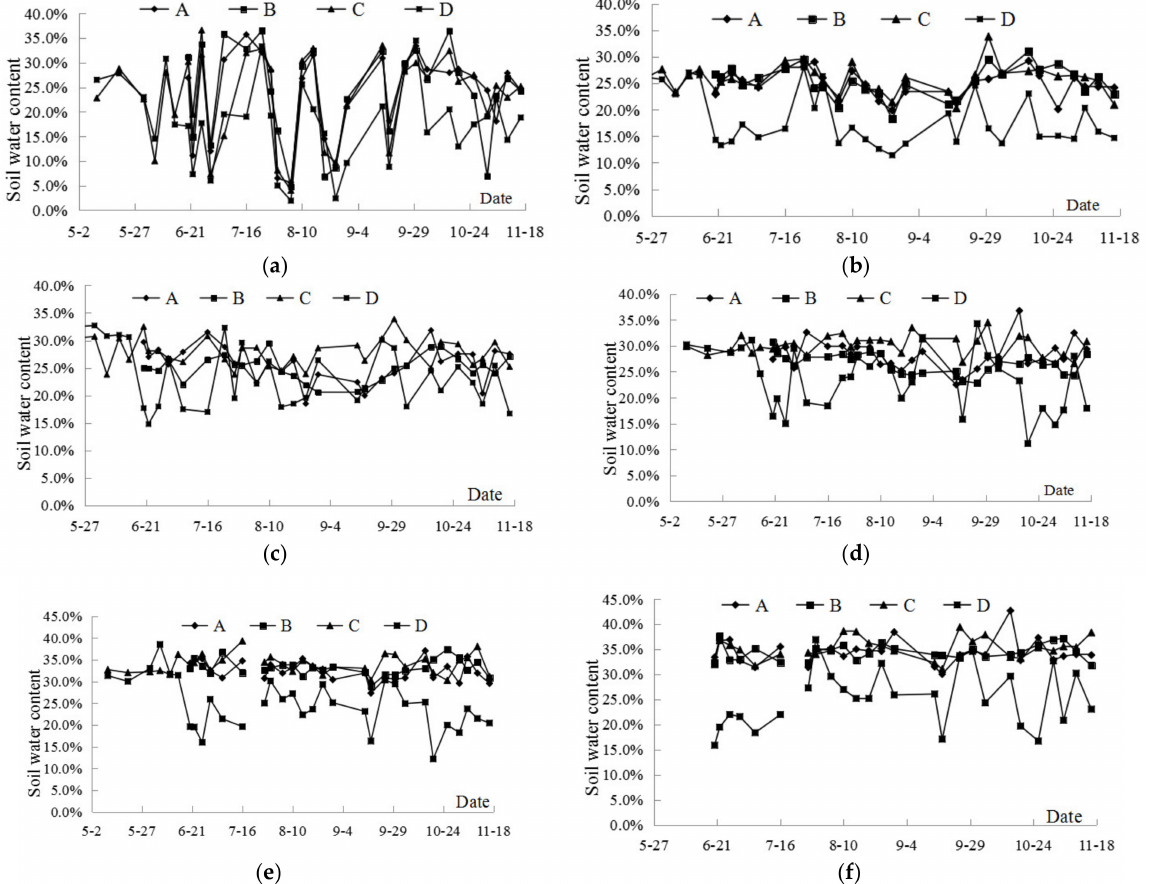
Figure 5. Variation in the soil water content in the different layers during the cotton growth period in the field in 2010. ( a ) Soil water content at the surface; ( b ) Soil water content in the 20 cm layer; ( c ) Soil water content in the 40 cm layer; ( d ) Soil water content in the 60 cm layer; ( e ) Soil water content in the 80 cm layer; ( f ) Soil water content in the 100 cm